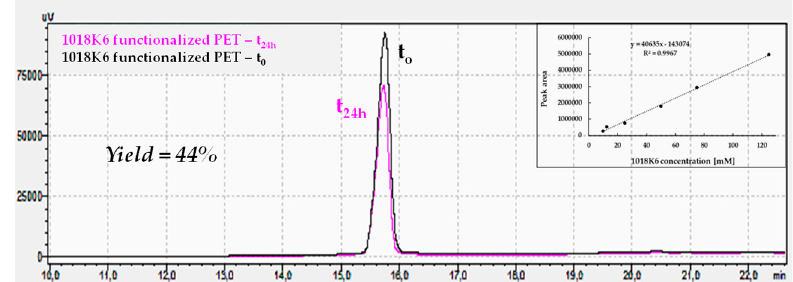
Figure 4 . Immobilization yield (%) of 1018K6 on PET surface determined by reverse-phase HPLC chromatography on a C18 column after the coulping reaction (24 h). Pre-activated PET surfaces by plasma were incubated for 24 h with 1018K6 (50 µM) in PBS pH 7.0. The solutions recovered after incubation were further analysed. The peptide solution placed in contact with the pre-activated surface at time 0 ( t = 0) was used as control. The chromatograms are representative of three independent experiments. Insert : Calibration curve of the C18 column obtained using different 1018K6 concentrations .